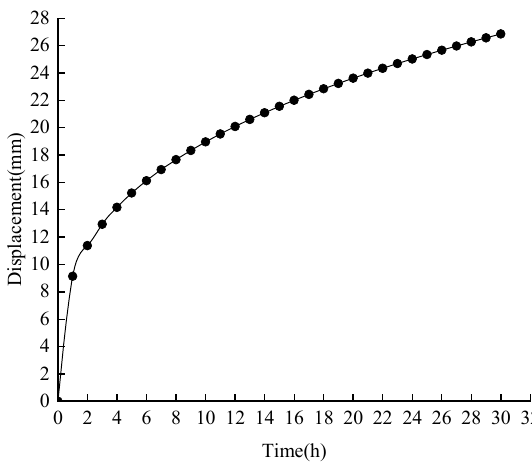
Figure 12. Variation in the displacement of shaft wall with time.